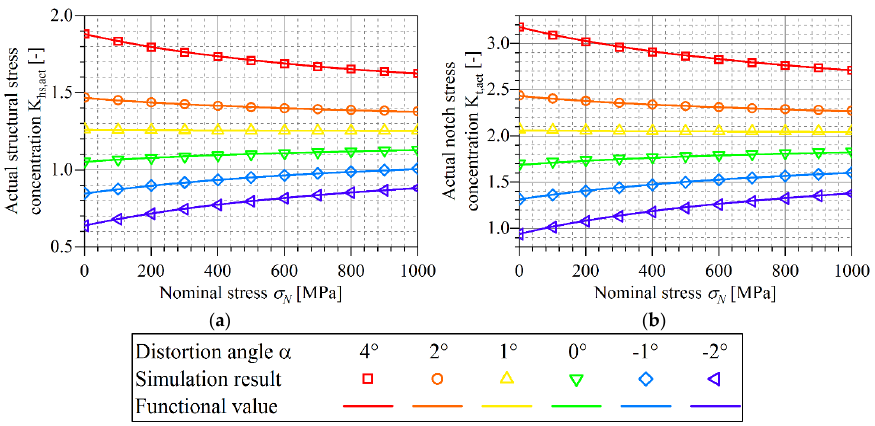
Figure 16. Comparison of simulation results and the function output. ( a ) Actual structural stress concentration; ( b ) Actual effective notch stress concentration. Table 6. Parameter-set for Equation (7) obtained by the least-square fit.